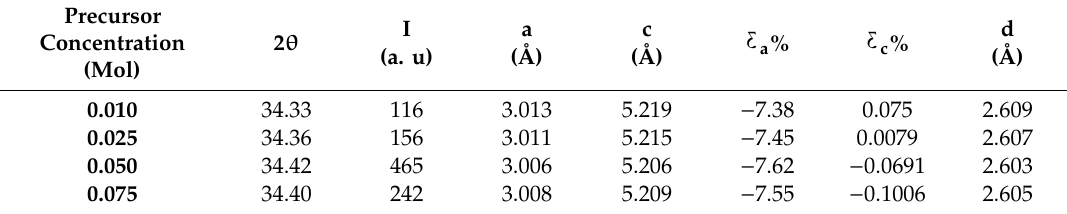
Table 1. Lattice parameters and structure properties of di ff raction peak (002) at di ff erent precursor concentrations of ZnO nanorods synthesized by conventional CBD method.